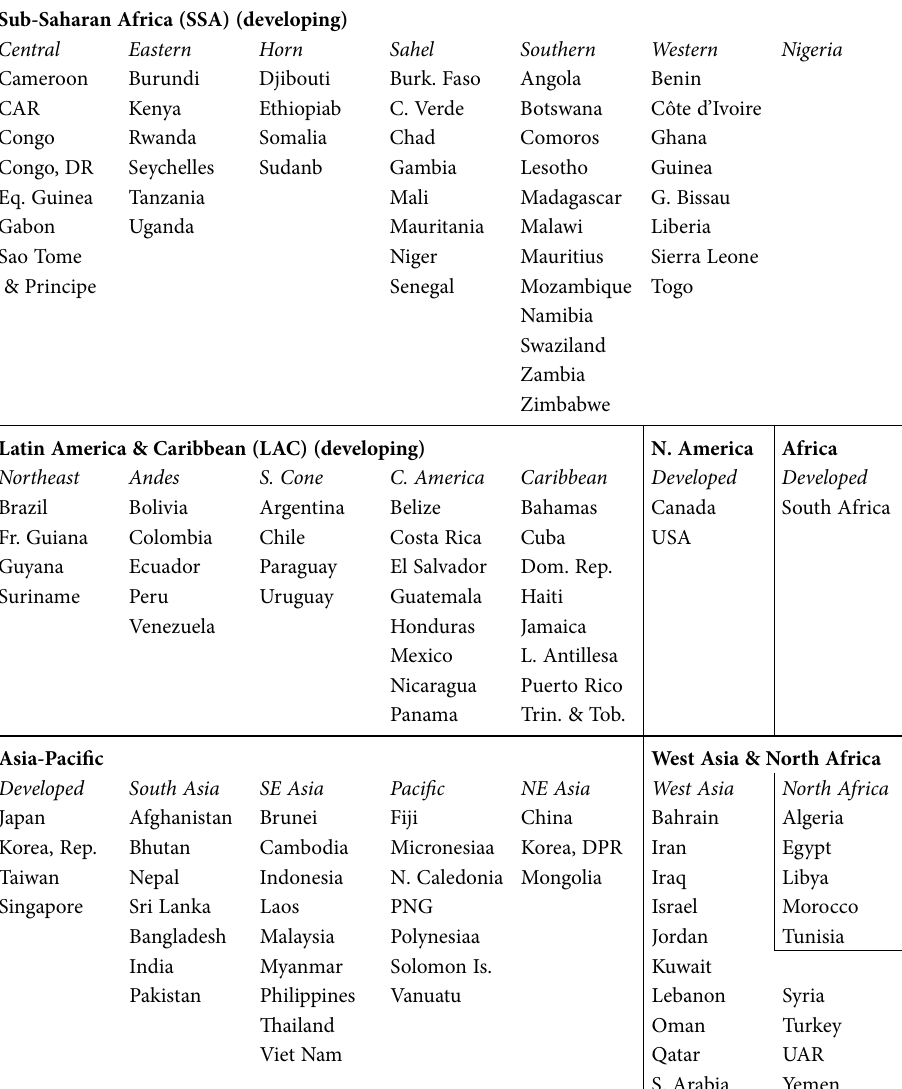
Table A3. Countries and Regional Groupings Included in the Productivity Analysis. Sub-Saharan Africa (SSA) (developing)